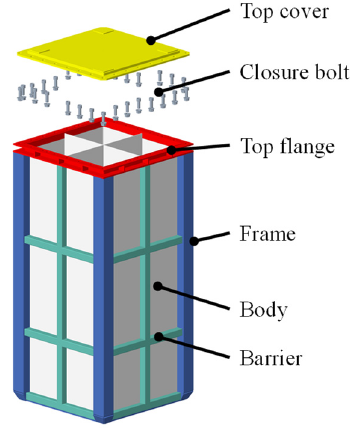
Figure 5. The three-dimension model of the SFE canister.